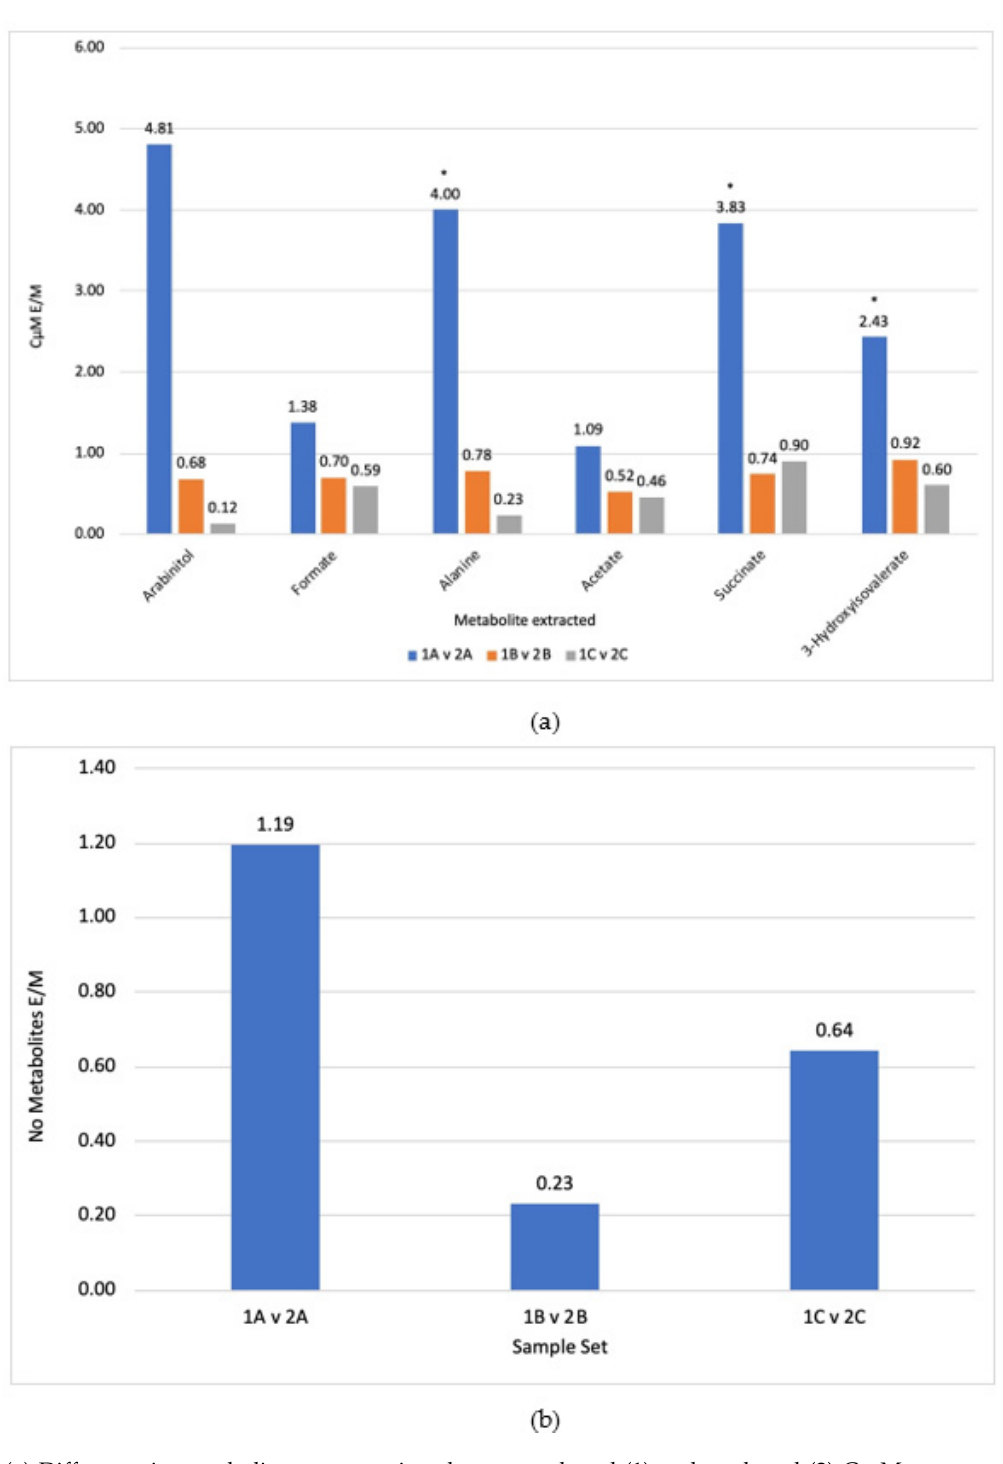
Figure 1. ( a ) Difference in metabolite concentrations between ethanol (1) and methanol (2) C µM E/M extractions for the triplicates A–C. ( b ) Difference in the number of different metabolites extracted between ethanol (1) and methanol (2) extractions N E/M for the triplicates. Numbers below 1.0 indicate an increased extraction in methanol, * = outliers, numbers above the bars indicate measured ratios.